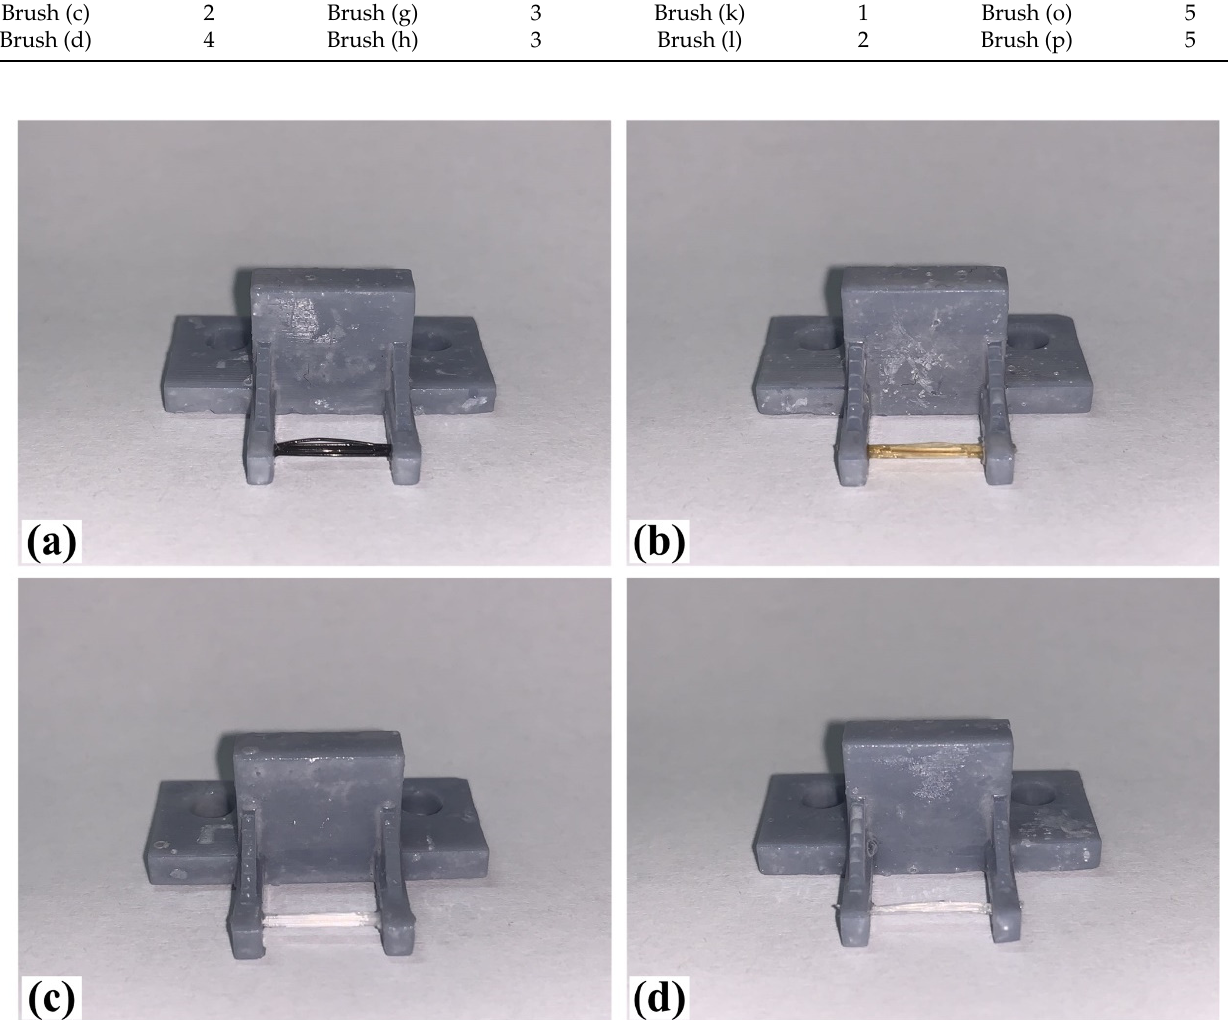
Figure 10. Vertical brushing micro-manipulators made of different materials: ( a ) nylon; ( b ) bristles; ( c ) nanometer-silk; ( d ) wool. All four brushes are 1mm in diameter and 10mm in length.